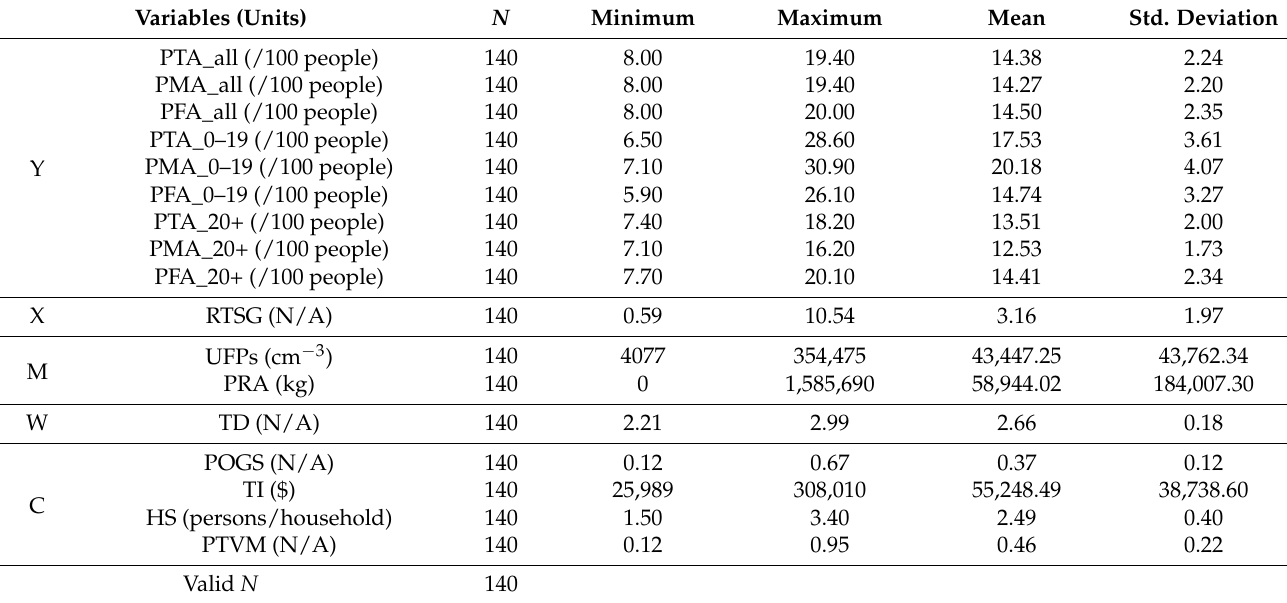
Table 2. Descriptive statistics (before